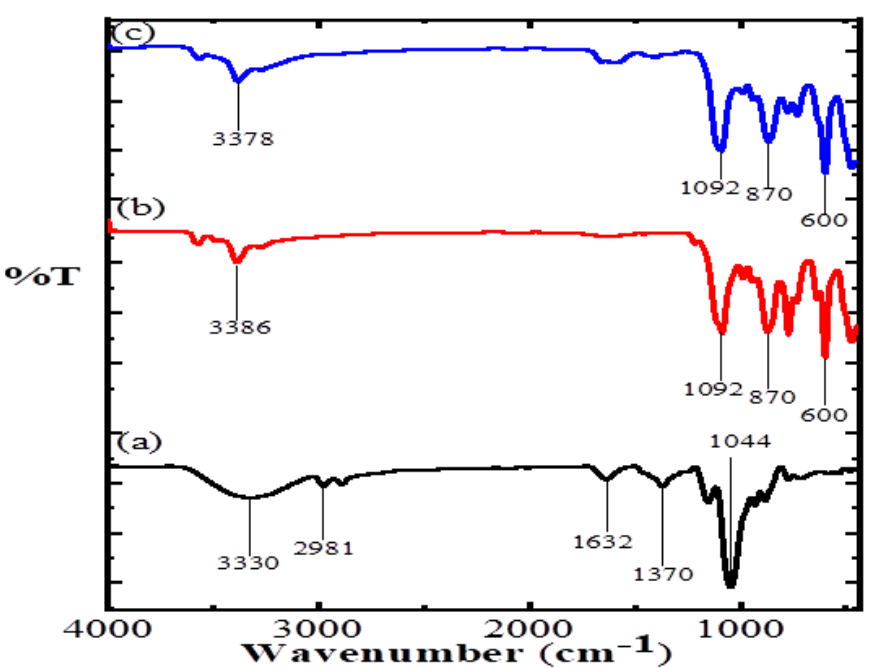
Figure 1. FTIR spectrum of ( a ) Agar agar, ( b ) CuO and ( c ) CuO/Alg-Agar BNC. Table 2. FTIR vibrational frequency peaks of CuO/Alg-Agar BNC and corresponding functional groups.